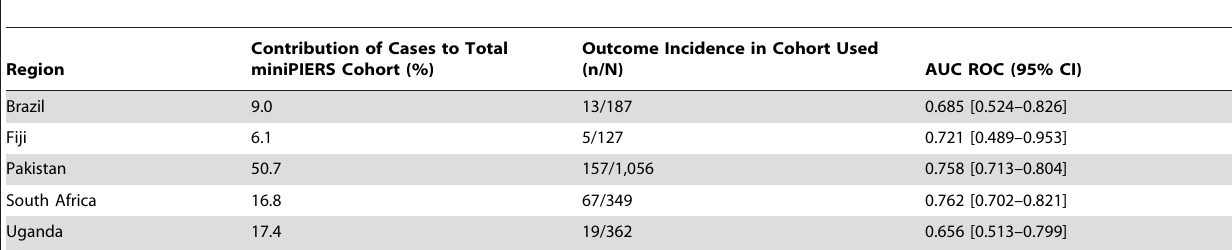
Table 7. Performance of the model in each study site region as a predictor of combined adverse maternal outcome occurring within 48 hrs of